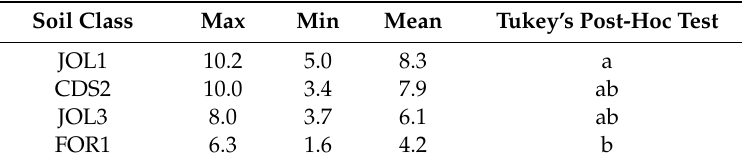
Table 6. Maize above ground biomass (t ha − 1 ) measured during the last field campaign of 2018 (BBCH 65) and analyzed by the ANOVA method (di ff erent letters are significantly di ff erent at p < 0.05). Soil Class Max Min Mean Tukey’s Post-Hoc Test